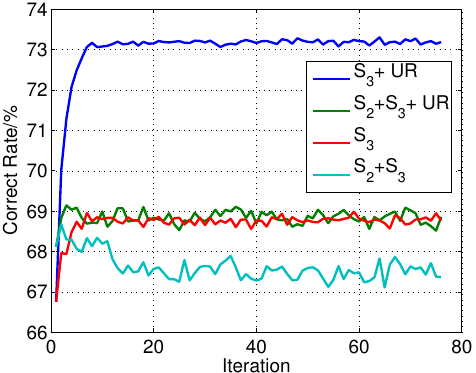
Figure 7: Comparison of sample selection strategies and impact of uncertainty information. S 2 and S 3 refer to sample selection from Figure 4. + UR indicates removal of uncertain samples from training set.